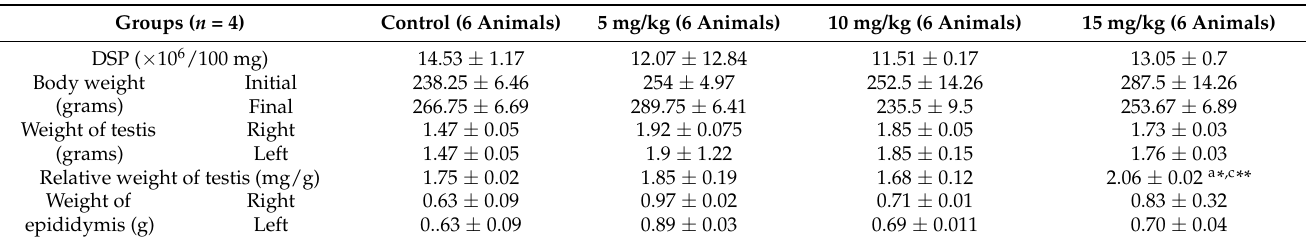
All values are expressed as mean ± SEM ( a = comparison to control, c = comparison to 10 mg/kg group. Probability: * = p < 0.05 and ** = p <